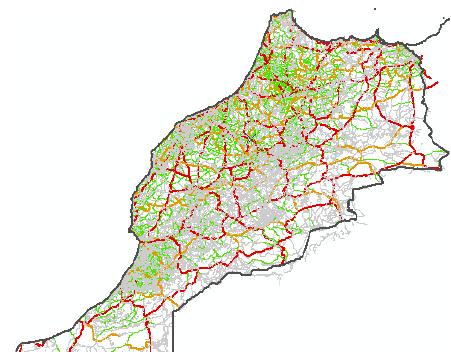
Figure 8. Traffic lines classification in Morocco